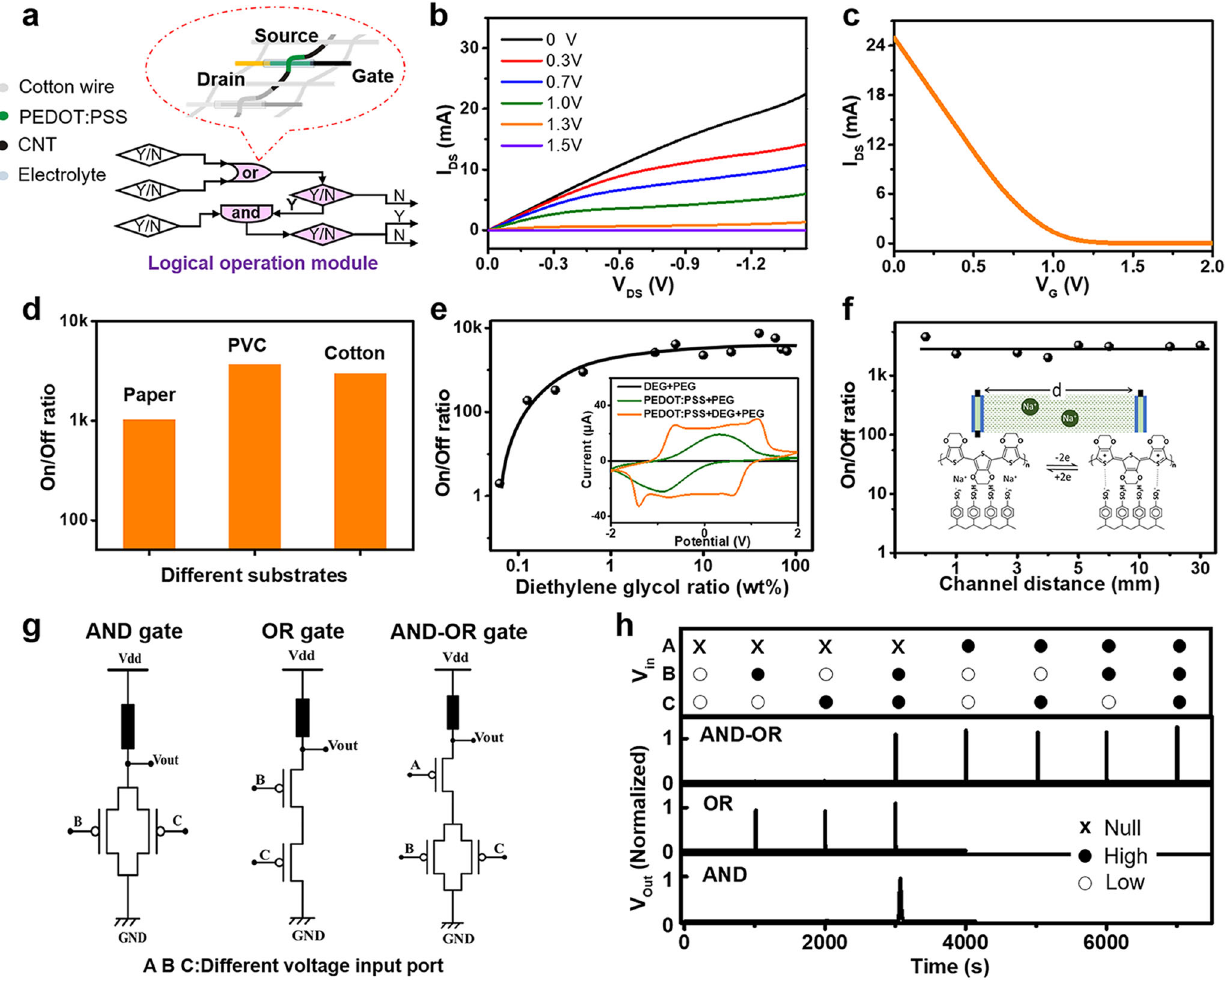
Fig. 2 The performance of the logical operation module. a The device structure of the woven transistor unit in a logical operation circuit. b Electric characteristics of a woven transistor unit. c Transfer characteristics of a woven transistor unit. d The on/off ratio of the transistor based on different substrates. e The on/off ratio of the woven transistor unit with different diethylene glycol ratio in the PEDOT: PSS layer. Insert is the cyclic voltammetry scanning between the gate electrode and the source electrode for PEDOT:PSS layer with different compositions. f The on/off ratio of the fabric-type transistor with different channel distance. g the logic circuit design for AND gate, OR gate, AND-OR gate. h The logic function characteristics of the three types of logic